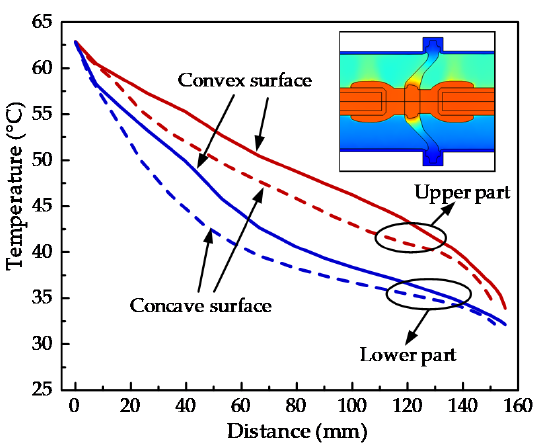
Figure 8. Surface temperature distribution along the spacer–symmetry plane interface.